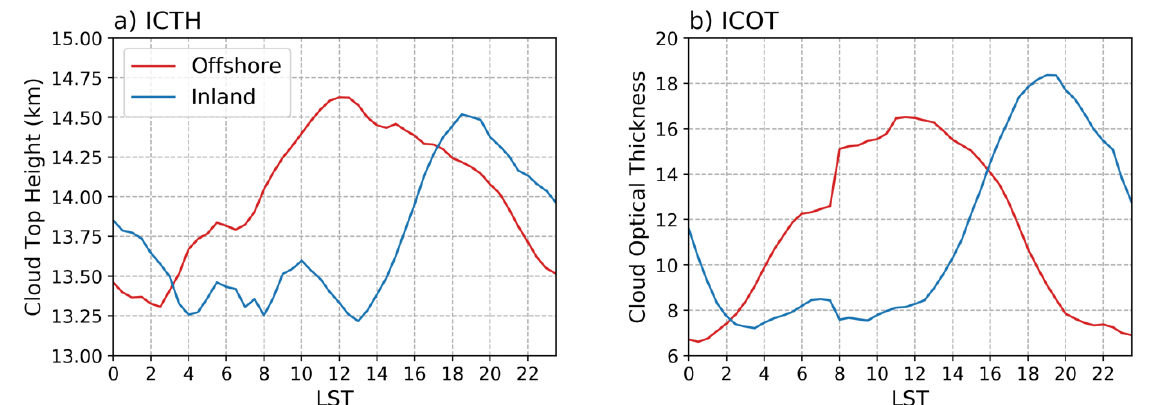
Figure 6. Quantitative demonstration of the results in Figures 4 and 5 for the area-averaged ( a ) ICTH (km) and ( b ) ICOT. Results for the offshore and inland areas are denoted by red and blue lines, respectively.